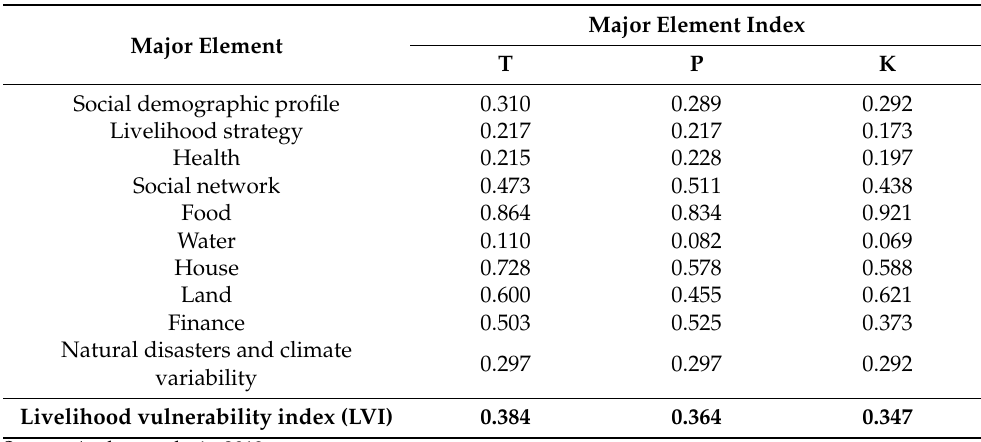
Table 4. Summarised indexed subcomponents, main components, and total LVI for the districts of Temerloh, Pekan and